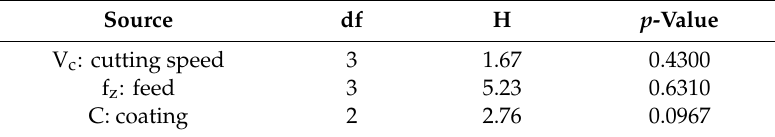
Table 3. Kruskal–Wallis test results for the cutting